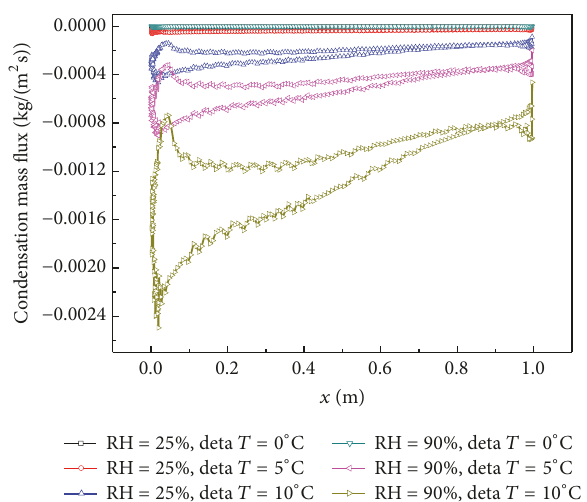
Figure 6: Condensation mass flux around airfoil for RH = 25% and RH = 90% using VF model.